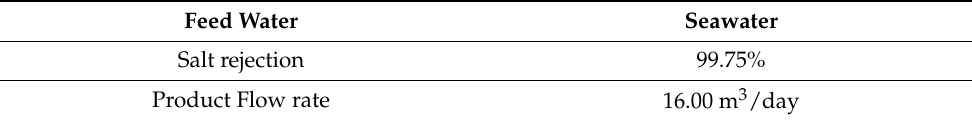
Table 1. Technical specifications of the RO